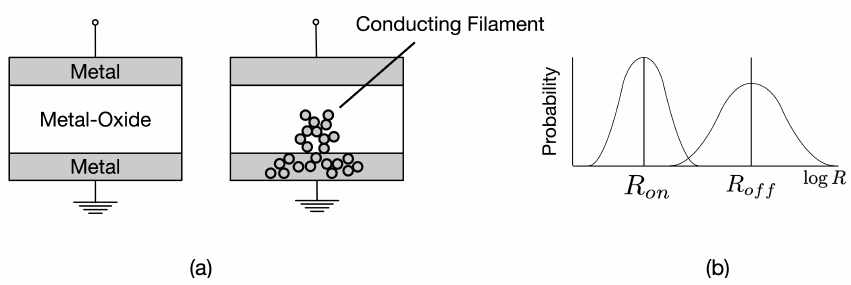
Figure 5. ( a ) Conducting Filament of ReRAM. ( b ) Lognormal distribution of ReRAM.